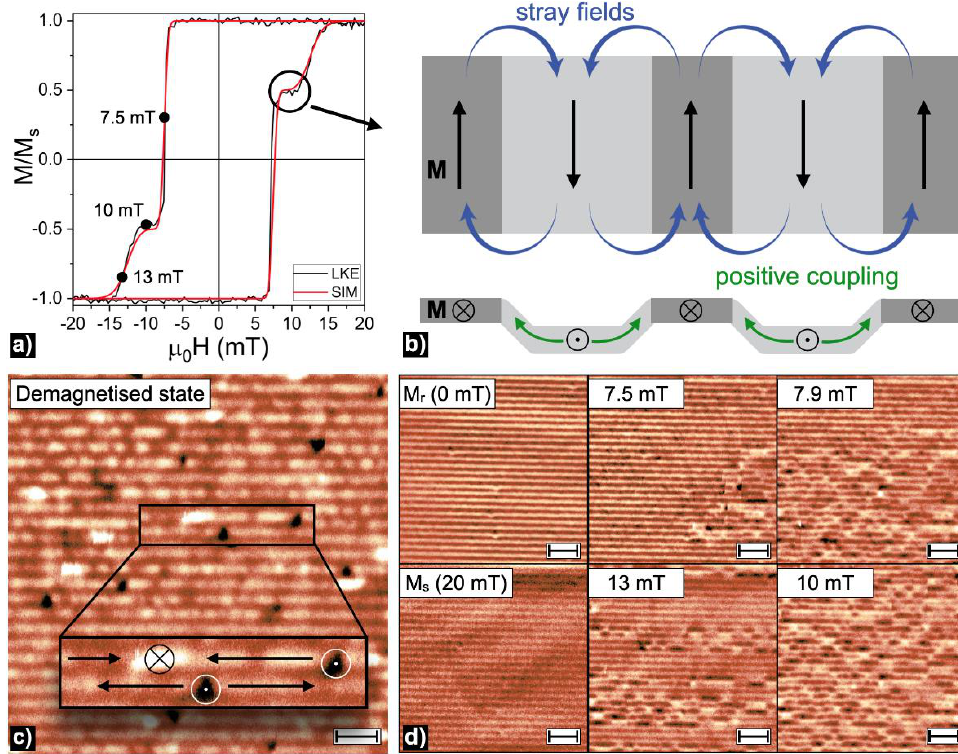
Figure 2. ( a ) Local and simulated hysteresis loops along the EMA direction. ( b ) The schematic image of the structure’s bottom, side and top parts’ magnetization distribution in the hysteresis loop’s plateau region. Arrows show the magnetization direction M (black), positive coupling (green) between bottom and side parts, and stray field (blue) delaying magnetization reversal of the top parts. The MFM images of magnetic microstructure in ( c ) the demagnetized state, the scale bar is 2 μ m, and ( d ) magnetic microstructure dynamics with the scale bars of 5 μ m. Arrows in the inset of panel ( c ) indicate an orientation of magnetization components at a given area on the top part of the stripes.